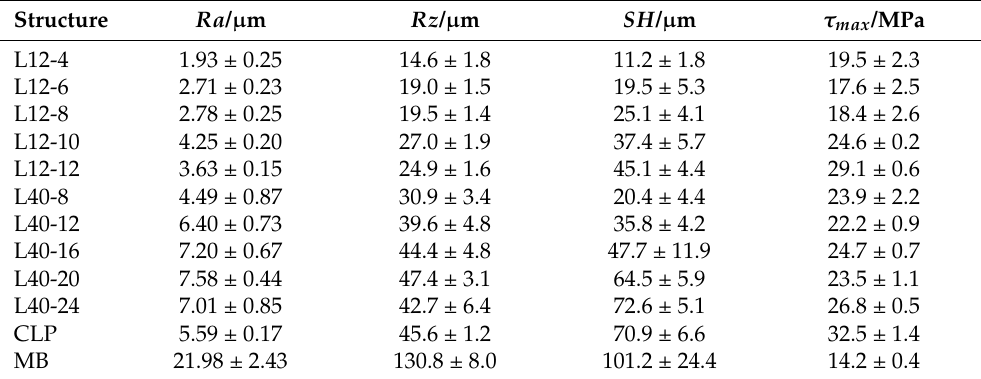
Table 4. Surface characteristics and shear strength of all investigated samples, mean values ± 1SD.